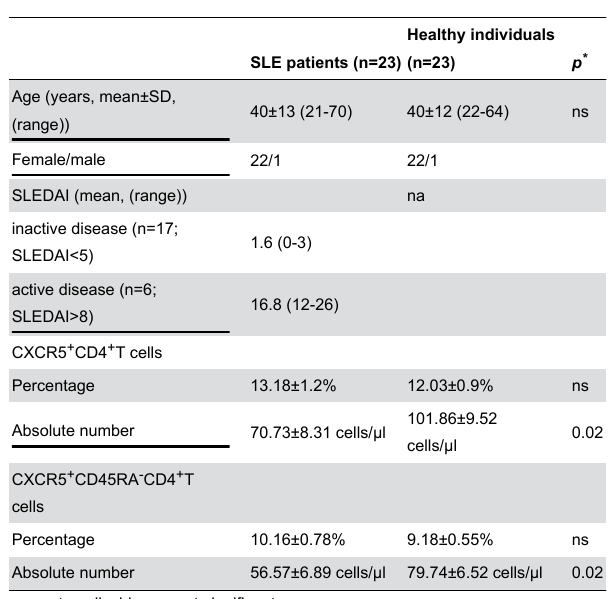
Table 1. Demographic characteristics and circulating CXCR5 + CD4 + T cell frequencies in SLE patients and healthy